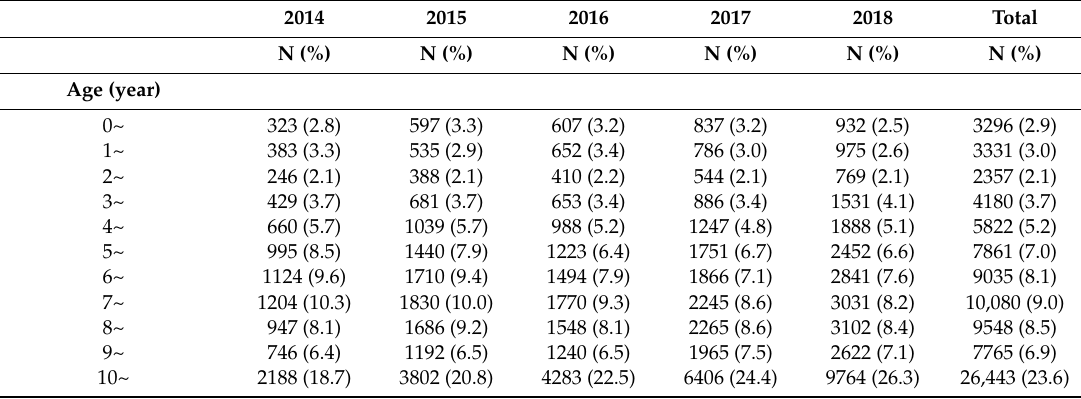
Table 1. Demographic characteristics of varicella cases in Chongqing,